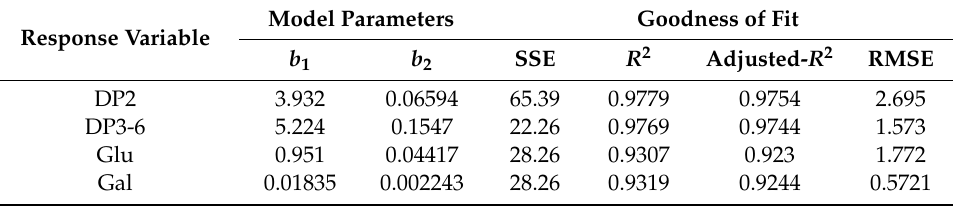
Table 2. Estimated regression coe ffi cients and goodness of fit